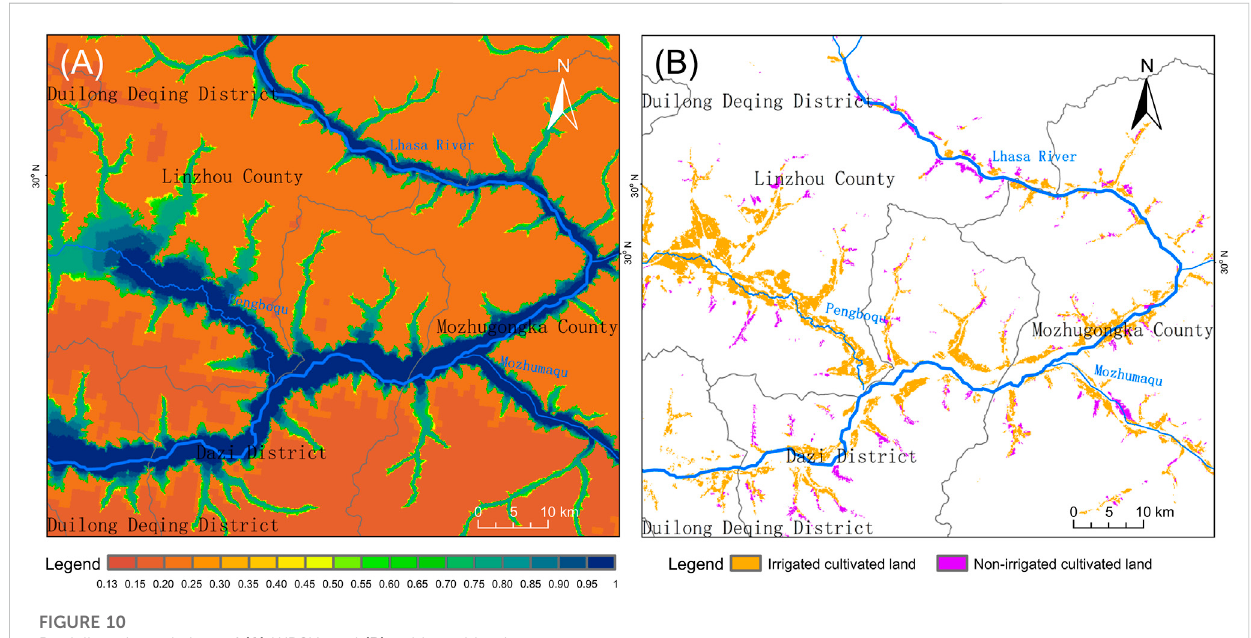
FIGURE 10 Partially enlarged view of (A) WRSIA and (B) cultivated